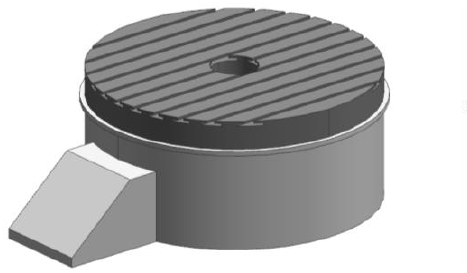
Figure 4. Kinematic model of the rotary table.